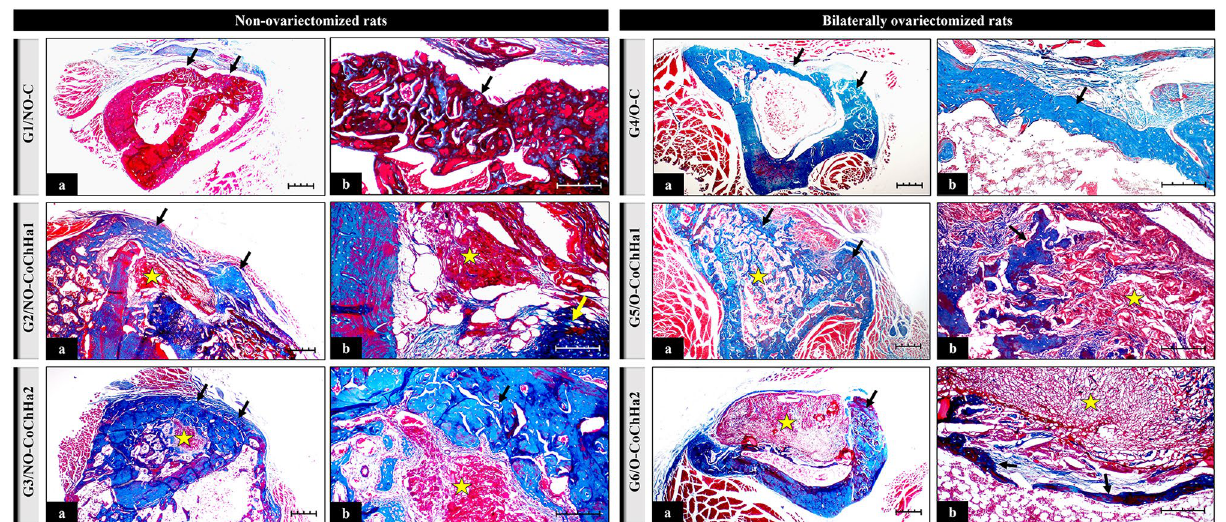
Figure 3. Photomicrographs of histological slides stained with Masson’s trichrome at ×4 ( a ) and ×10 magnification ( b ) obtained from the groups of non-ovariectomized and bilaterally ovariectomized rats. The arrows point to areas of bone neoformation. The star indicates the presence of biomaterial undergoing bioresorption. Scale bar: 20